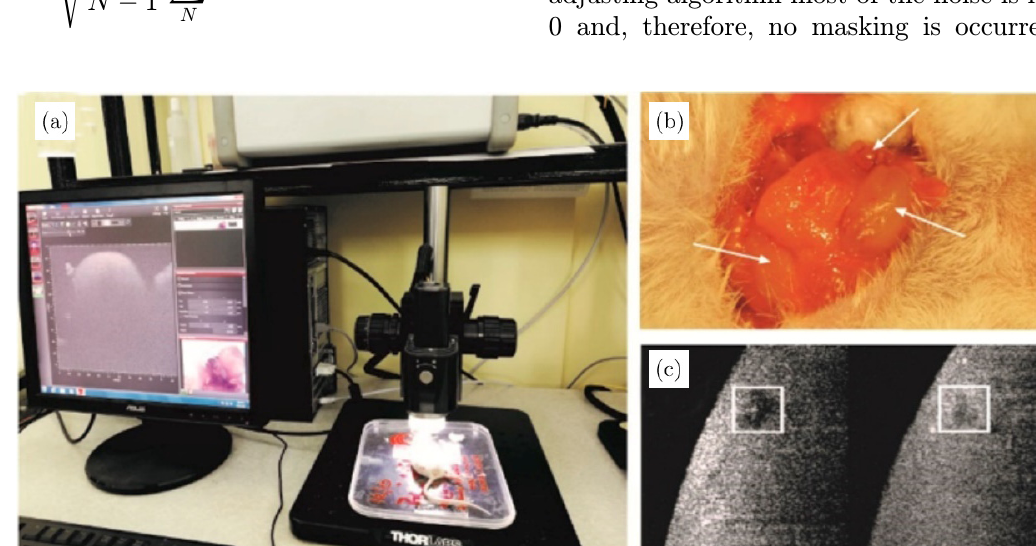
Fig. 9. Time-dependent B-scan intensity changes as the local concentration of GNRs increases: (a) scheme of OCT measurement of GNRs accumulation in deep cervical lymph node; (b) anatomical position of the deep and super¯cial cervical lymph nodes in the neck of mice; (c) example of OCT image of deep cervical lymph node before and 60 min after the start of OCT recording (more bright square means a bigger concentration of GNRs in the deep cervical lymph